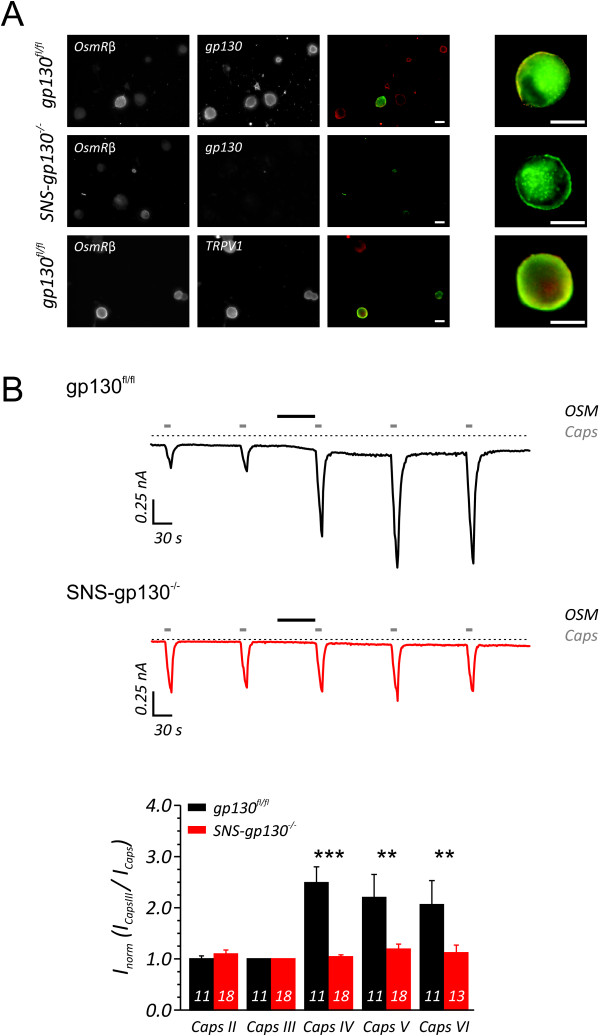
OSM requires the expression of gp130 in nociceptive neurons to potentiate capsaicin-evoked currents. (A) Expression of OSMR, gp130 and TRPV1 in gp130fl/fl and SNS-gp130-/- cultured DRG neurons. OSMR and gp130 immunoreactivity was observed in gp130fl/fl DRG neurons (upper panel). In addition, the OSMR-positive neurons of gp130fl/fl mice also displayed TRPV1 immunoreactivity (middle panel). The SNS-gp130-/- DRG neurons were devoid of gp130 (lower panel) while maintaining OSMR expression. Scale bar 10 μM. (B) In electrophysiological recordings of gp130fl/fl neurons OSM (5 ng/ml) induces a transient potentiation of capsaicin-responsive currents (upper trace), whereas in DRG neurons lacking the gp130 expression OSM did not increase the capsaicin-induced currents (lower trace). Quantification of normalized ionic currents (Icaps/IcapsIII) reveals that OSM increases capsaicin currents approximately 2.5 fold within 2 minutes in OSMR-positive gp130 nociceptors compared to the normalized currents recorded in OSMR-positive/gp130-negative SNS-gp130-/- nociceptive neurons. ** p < 0.01, *** p < 0.001, Mann-Whitney U-test, white numbers inside the individual bars indicate the number of recorded Icaps.